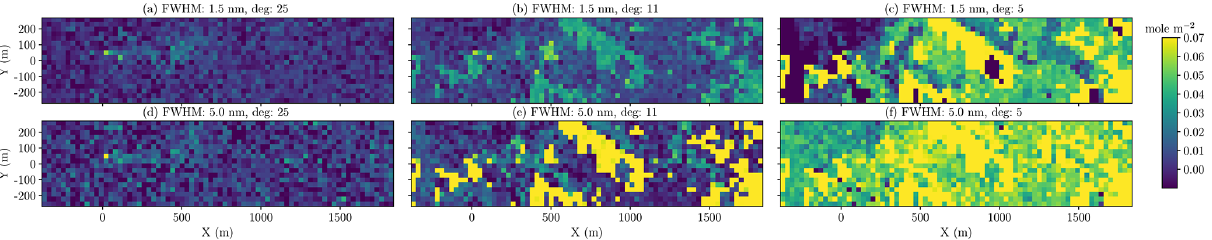
Figure 17. A plot similar to Fig. 16 but at 30m resolution. Retrieved CH 4 column over a well pad in the Durango, Colorado, area with varying instrument FWHM and polynomial degrees in the retrieval. The realistic surface distribution is based on LANDSAT data. The use of a polynomial degree of 25 and a FWHM of 1.5nm can reduce biases and precision errors across the scene.